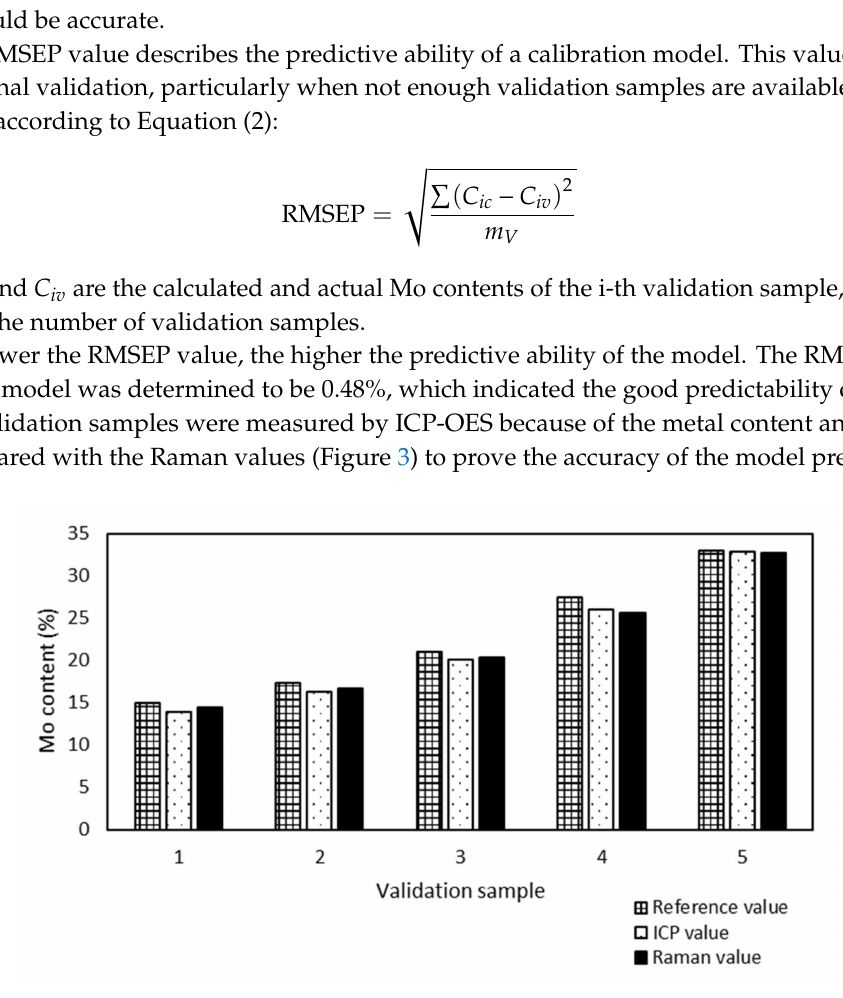
Figure 3. Comparison of inductively coupled plasma optical emission spectroscopy (ICP-OES) and Raman values of Mo content of validation samples supported SBA-15. The maximum absolute di ff erence is 0.6% (sample 1) and the minimum is 0.1% (sample 5). Samples no. 1 and 5 presented the maximum (0.6%) and minimum (0.1%) absolute di ff